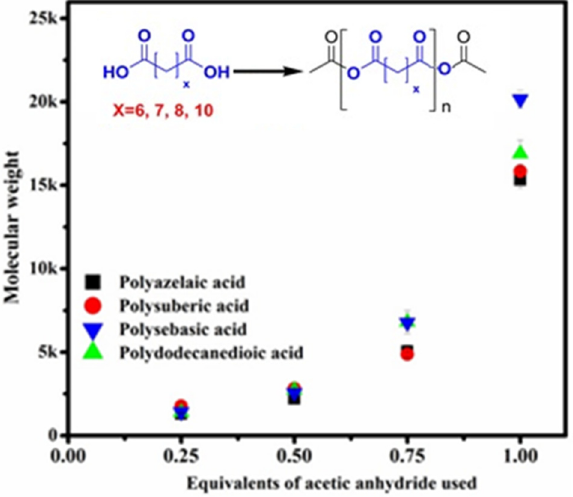
Figure A1. Table of Contents Figure.